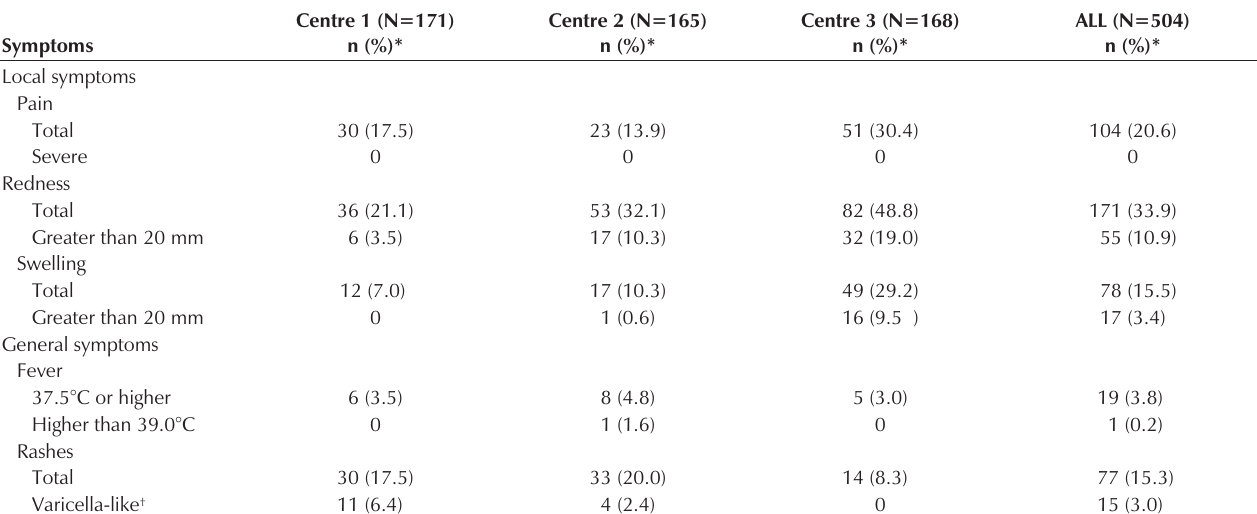
Rates of solicited symptoms after vaccination including local (day 0 to 7), fever (day 0 to 3) and varicella-like rashes (day 0 to